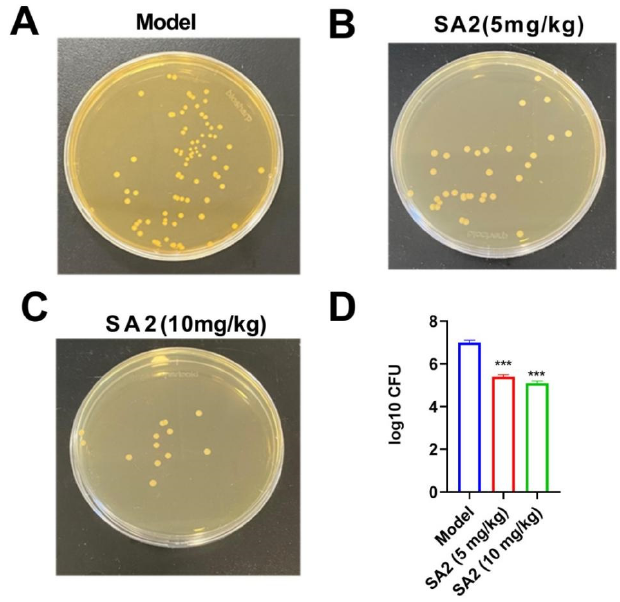
Figure 6. MRSA USA300 bacterial numbers in the infection tissue of mice were measured in the infection model control group ( A ), the 5 mg/kg SA2 treatment group ( B ), and the 10 mg/kg SA2 treatment group ( C ). The colony-forming units from the model control and SA treatment mice tissue were analyzed, *** p < 0.001 vs. model group, n = 6 ( D ).